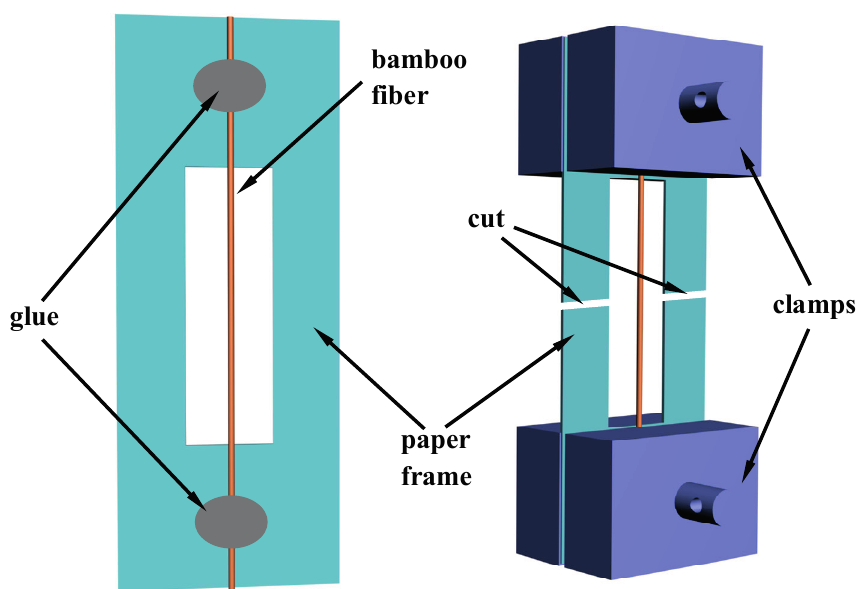
Figure 1. Schematic of the fixture set-up for the fiber tensile